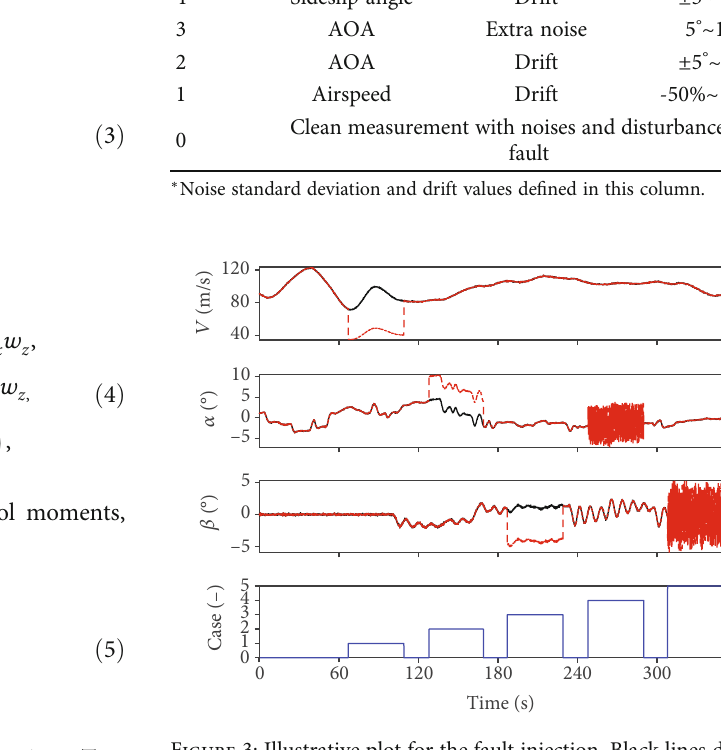
Figure 3: Illustrative plot for the fault injection. Black lines denote clean states from real fl ight/simulation, and red lines denote the fault-injected data. The FD scheme is expected to detect the di ff erent fault cases (blue thick line) based on available data measurements and proper DNN operations.